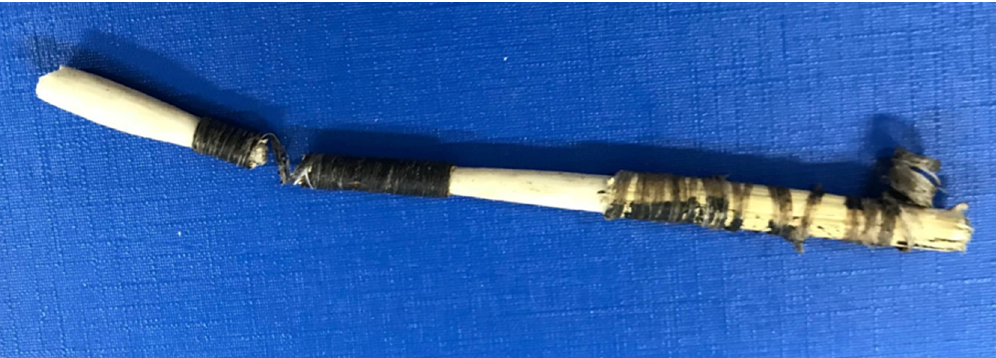
Figure 6. Failure occurs within the link-shaft joint under impact, while the bone arrowhead, the bone balance and the main shaft remain intact.